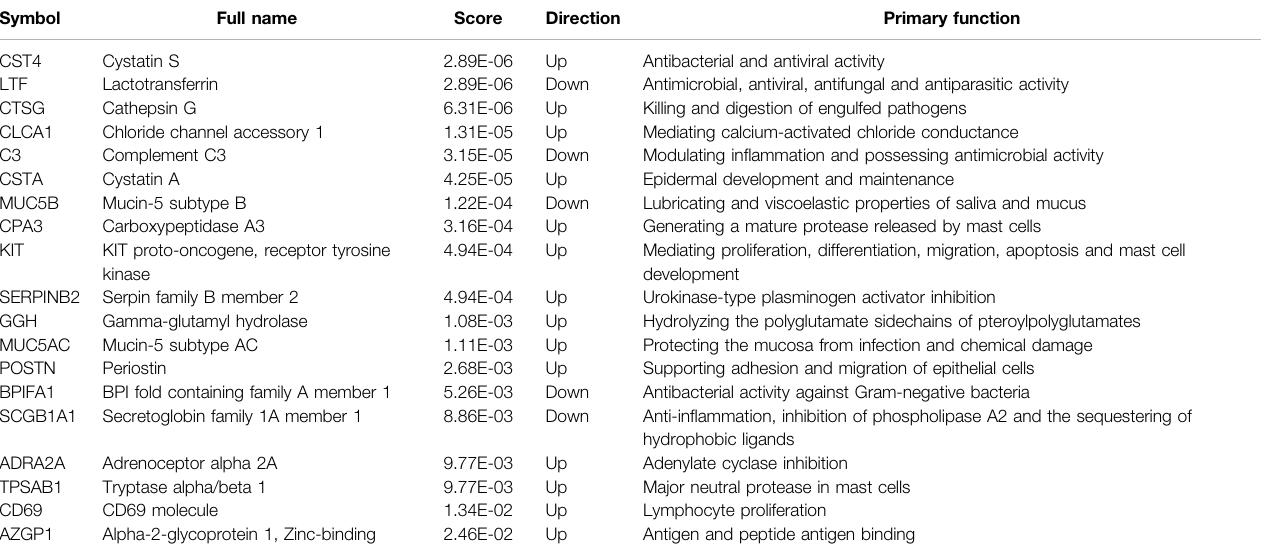
TABLE 2 | The detailed information of 19 hub